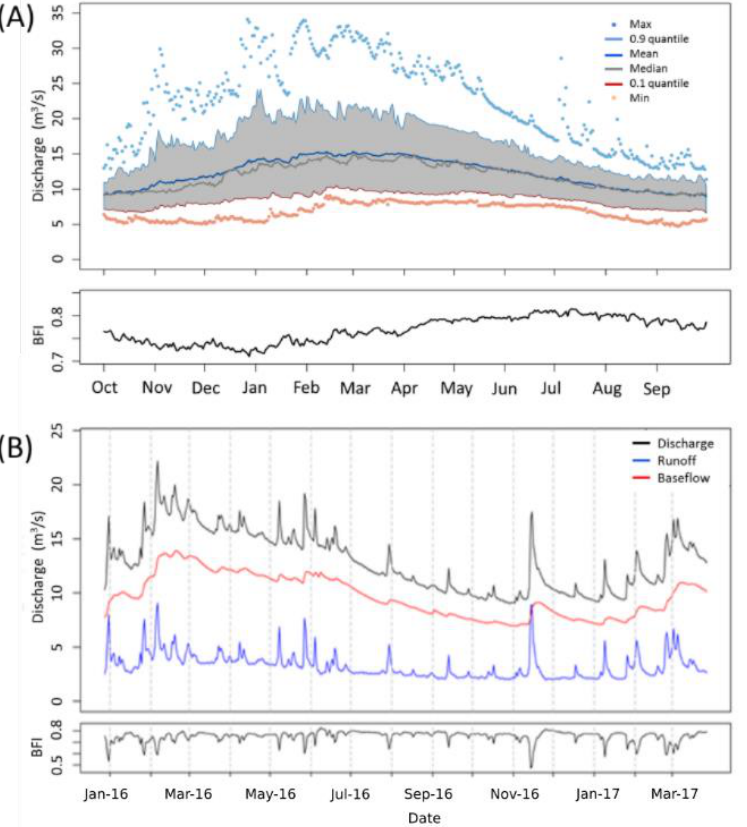
Figure 2. ( A ) Average flow regime of the Canche River and BFI over 44 years, ( B ) and the results of hydrograph separation over the study period.